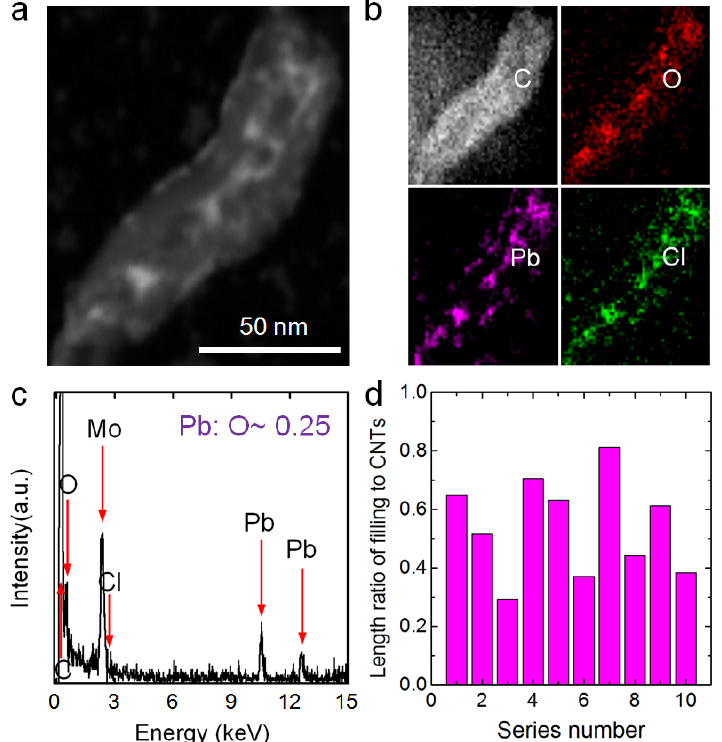
Figure 8. ( a ) An HAADF-STEM image of a PbCl 2 aggregation inside an ultra-short CNT. ( b ) EDS mappings of elements C, O, Pb and Cl corresponding to the area in ( a ). ( c ) EDS results for the aggregation in ( a ) (the Mo signal comes from the Mo sample grid). ( d ) Filling length/total length ratios for aggregations inside 10 random ultra-short CNTs.